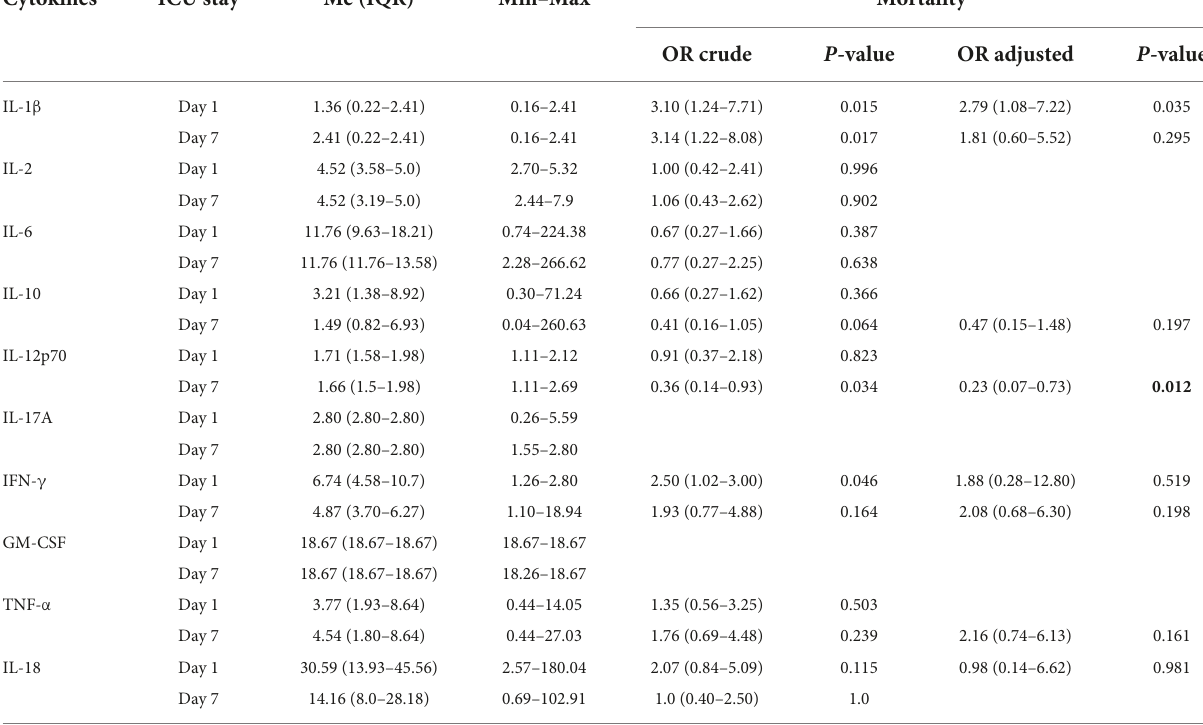
TABLE 2 Levels of the 10 cytokines and association with mortality on days 1 and 7 of ICU stay. Cytokines ICU stay Me (IQR) Min–Max Mortality OR crude P -value OR adjusted P